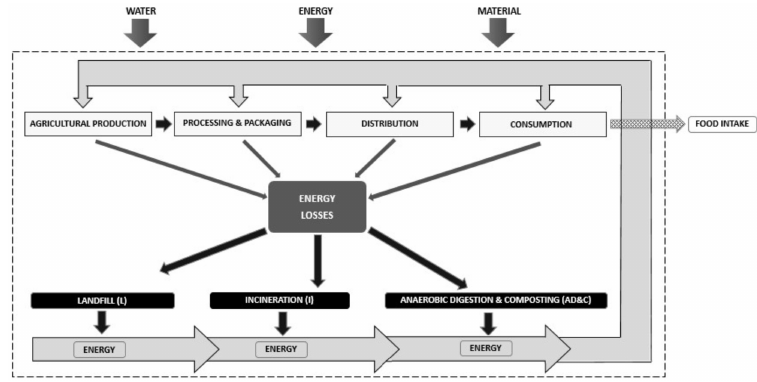
Figure 2. System boundaries, including the outline of the different considered